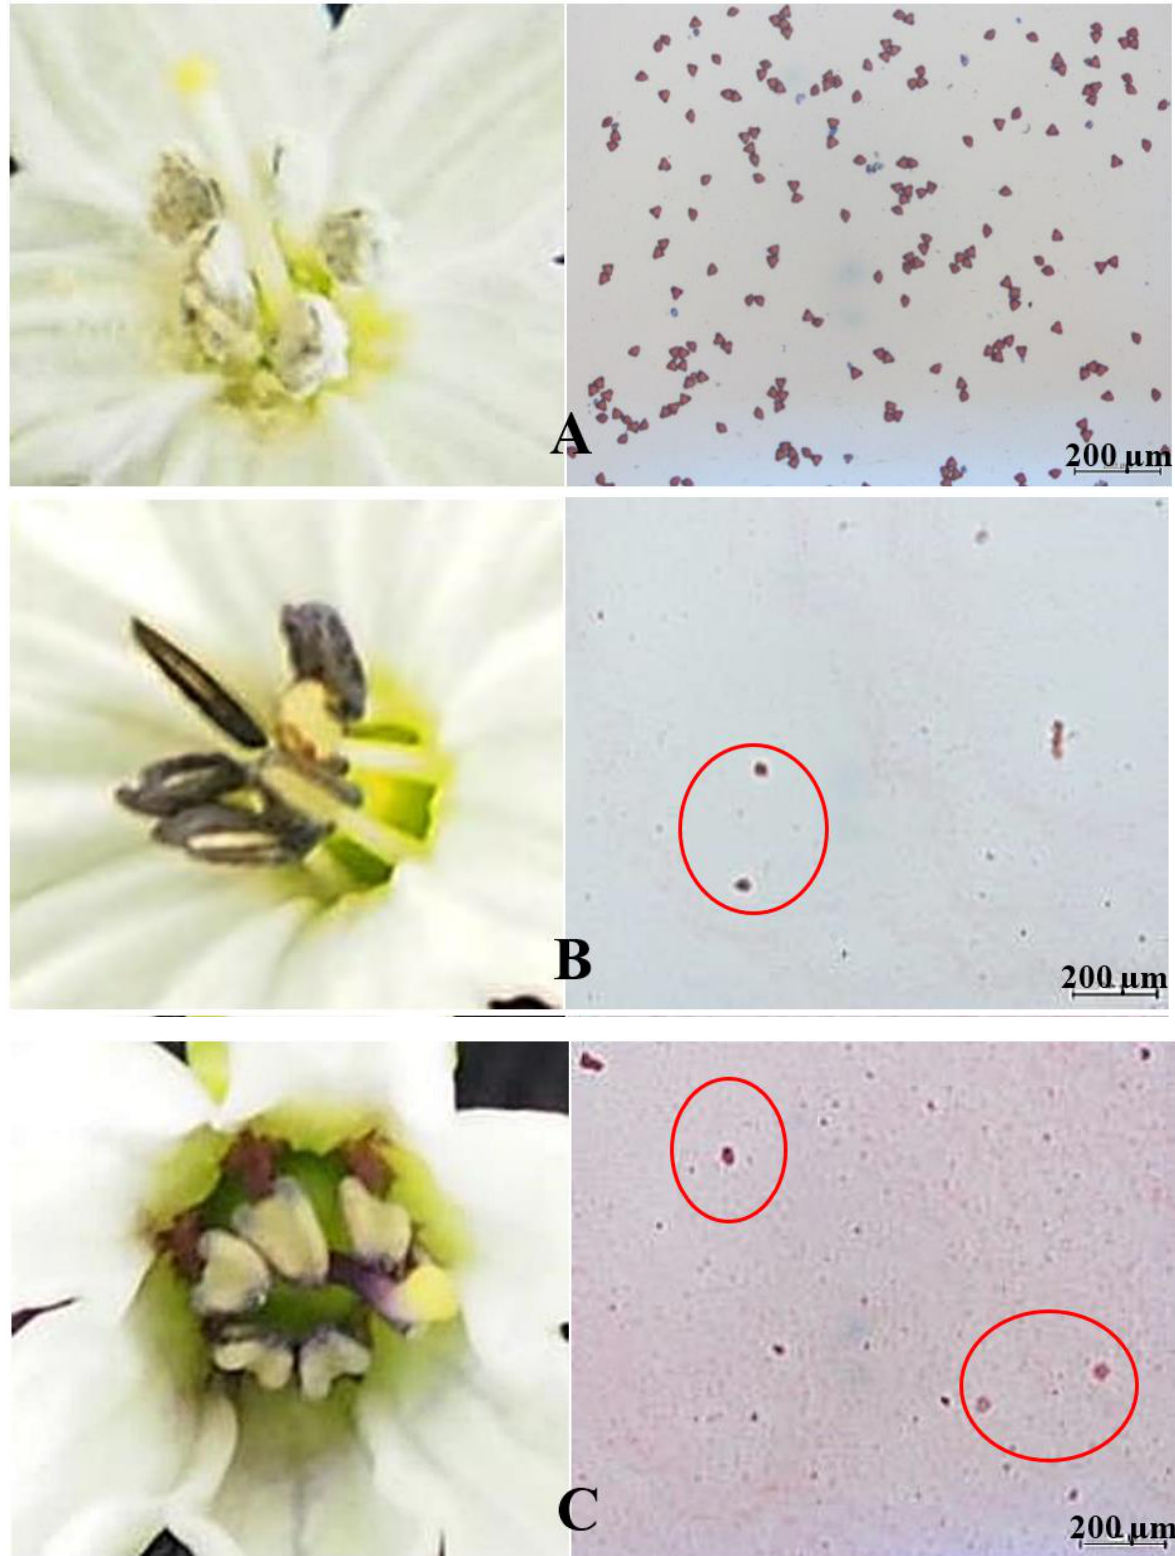
Figure 6. Morphological characteristics of flower and pollen grains observed under fluorescence microscopy of normal flower with fertile pollen as shown in B-line ( A ), male-sterile flower and non- viable pollen of BC 2 F 2 A1 × C1 ( B ), and male-sterile flower and non-viable pollen of BC 2 F 2 A1 × C3 ( C ). The red circle shows rudimentary pollen grains. Scale bars of pollen grains: 200 µm.